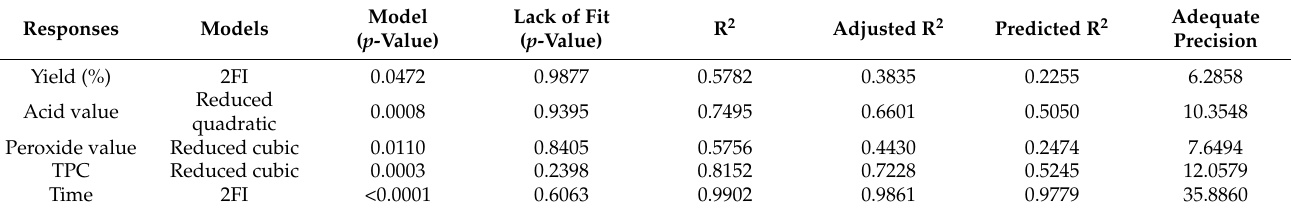
Table 3. Analysis of variance for the studied